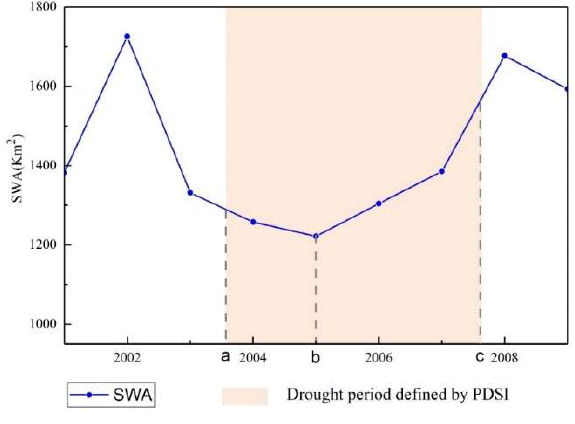
Figure 3. Schematic diagram of T reduce and T recovery . Table 1. Summary of data used in this study and their characteristics.